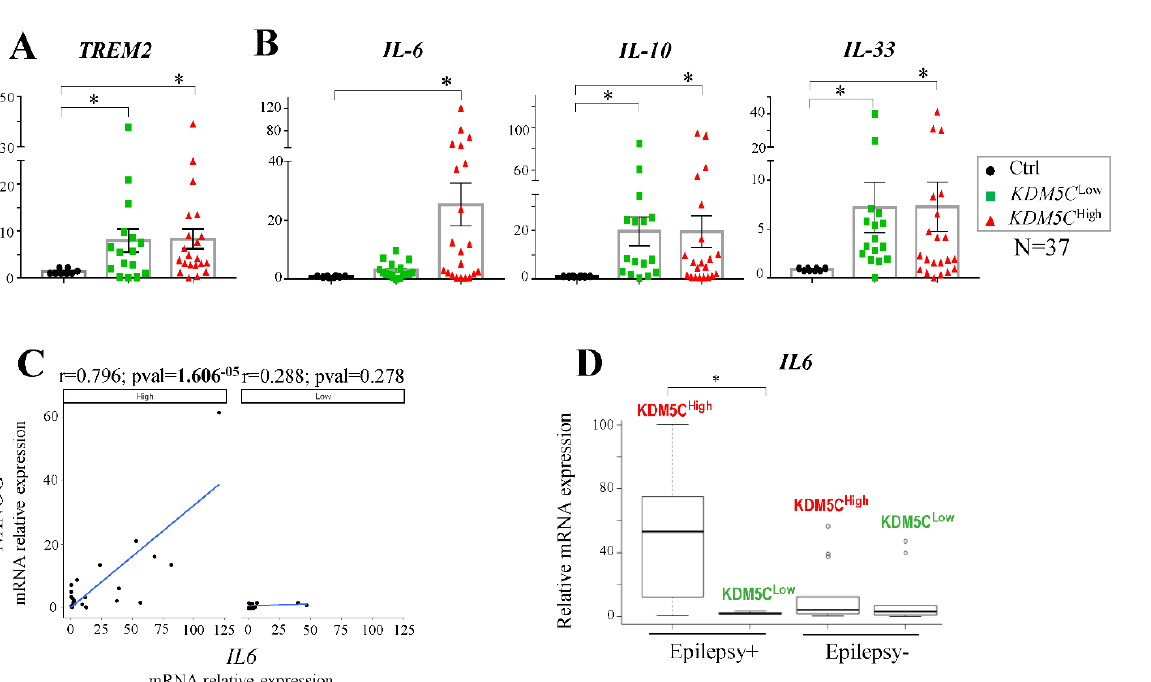
Figure 6. Expression profiles of TREM2 and proinflammatory cytokine genes in GBM tumor sam- ples. ( A , B ) RT-PCR assay in the KDM5C Low and KDM5C High subgroups. ( C ) Scatter plot reporting the correlation — by linear regression analysis — of NANOG and IL6 in the KDM5C Low and KDM5C High subgroups. ( D ) IL6 expression analysis in GBM patients with (Epilepsy+) or without epilepsy (Epilepsy − ). ( E , F ) RT-PCR assay in 5-ALA FGS tissues. Each transcript analysis was per- formed in triplicate, and the samples were normalized with the TBP gene. The bars indicate the mean ± SEM of repeated experiments. Asterisks indicate statistical significance compared with the healthy control samples: * p < 0.05. In the scatter plots, the average expression value of the healthy control samples was used as a reference. The Pearson’s correlation coefficient (r) and p -values ( p ) are indicated on the top of each plot. 3. Discussion The present work evaluated for the first time the association between alterations in the levels of the chromatin-oxygen sensor gene KDM5C and GBM pathogenesis. Based on the expression profile data in GBM tissues and the Cancer Genome Atlas (TCGA) data- base, we stratified GBM patients into two informative subtypes displaying high- and low-